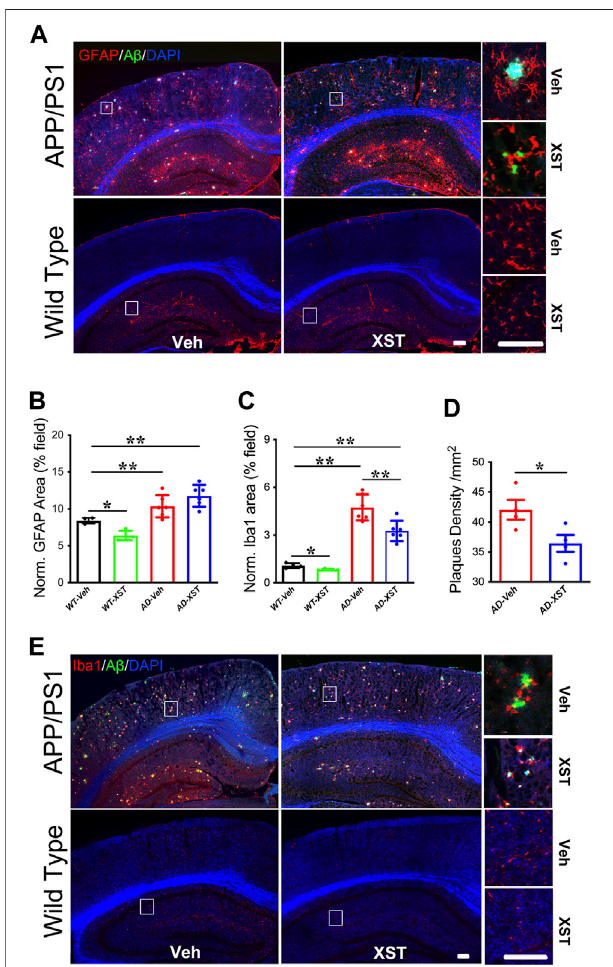
FIGURE 4 | Effect of XST on A β removal from the brains of APP/PS1 mice. (A) Sample images of amyloid plaques (A β , green) and astrocytes (GFAP, red) in the cortex and hippocampus of WT or APP/PS1 mice. Scale bar, 100 μ m. (B) Quanti fi cation of GFAP + area of in the brains of WT and APP/PS1 mice treated with XST or Veh (F (1, 16) (cid:2) 43.53, C57 vs. AD, p < 0.0001;C57-Veh vs. C57-XST, p (cid:2) 0.038, two-way ANOVA withBonferroni ’ s multiple comparisons). (C) Quanti fi cation of A β density in the brains of APP/ PS1 mice treated with XST or Veh (F (1, 16) (cid:2) 129.7, C57 vs. AD, p < 0.0001; AD-Veh vs. AD-XST, p (cid:2) 0.0028, two-way ANOVA with Bonferroni ’ s multiple comparisons). (D) Quanti fi cation of the area of Iba1 + in the brain of WT and APP/PS1 mice treated with XST or Veh ( p (cid:2) 0.0409, t -test, n (cid:2) 4 mice per group). (E) Sample images of amyloid plaque (A β , green) and microglia (Iba1, red) in the cortex and hippocampus of WT or APP/PS1 mice. Scale bars, 100 μ m. Data are mean ± SEM. * p < 0.05; ** p <